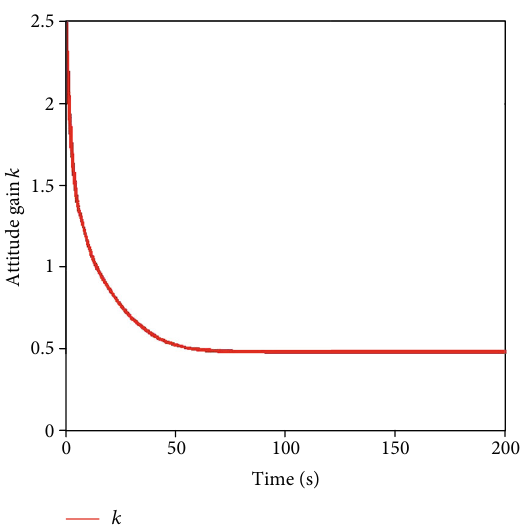
Figure 5: Time histories of attitude gain k in Case 1.